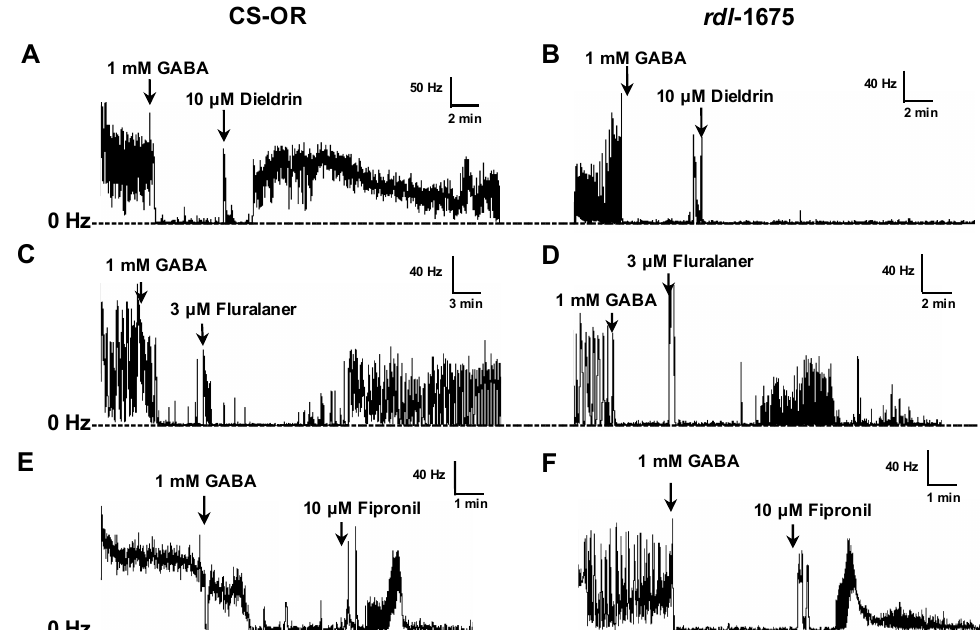
Figure 8. Electrophysiological recordings on severed D. melanogaster larval CNS, with GABA inhibition. Test compounds were added after 5-min incubation with 1 mM GABA. ( A ) CS-OR CNS treated with 10 µM dieldrin; ( B ) rdl -1675 CNS treated with 10 µM dieldrin; ( C ) CS-OR CNS treated with 3 µM fluralaner; ( D ) rdl -1675 CNS treated with 3 µM fluralaner; ( E ) CS-OR CNS treated with 10 µ M fipronil; ( F ) rdl -1675 CNS treated with 10 µ M fipronil.